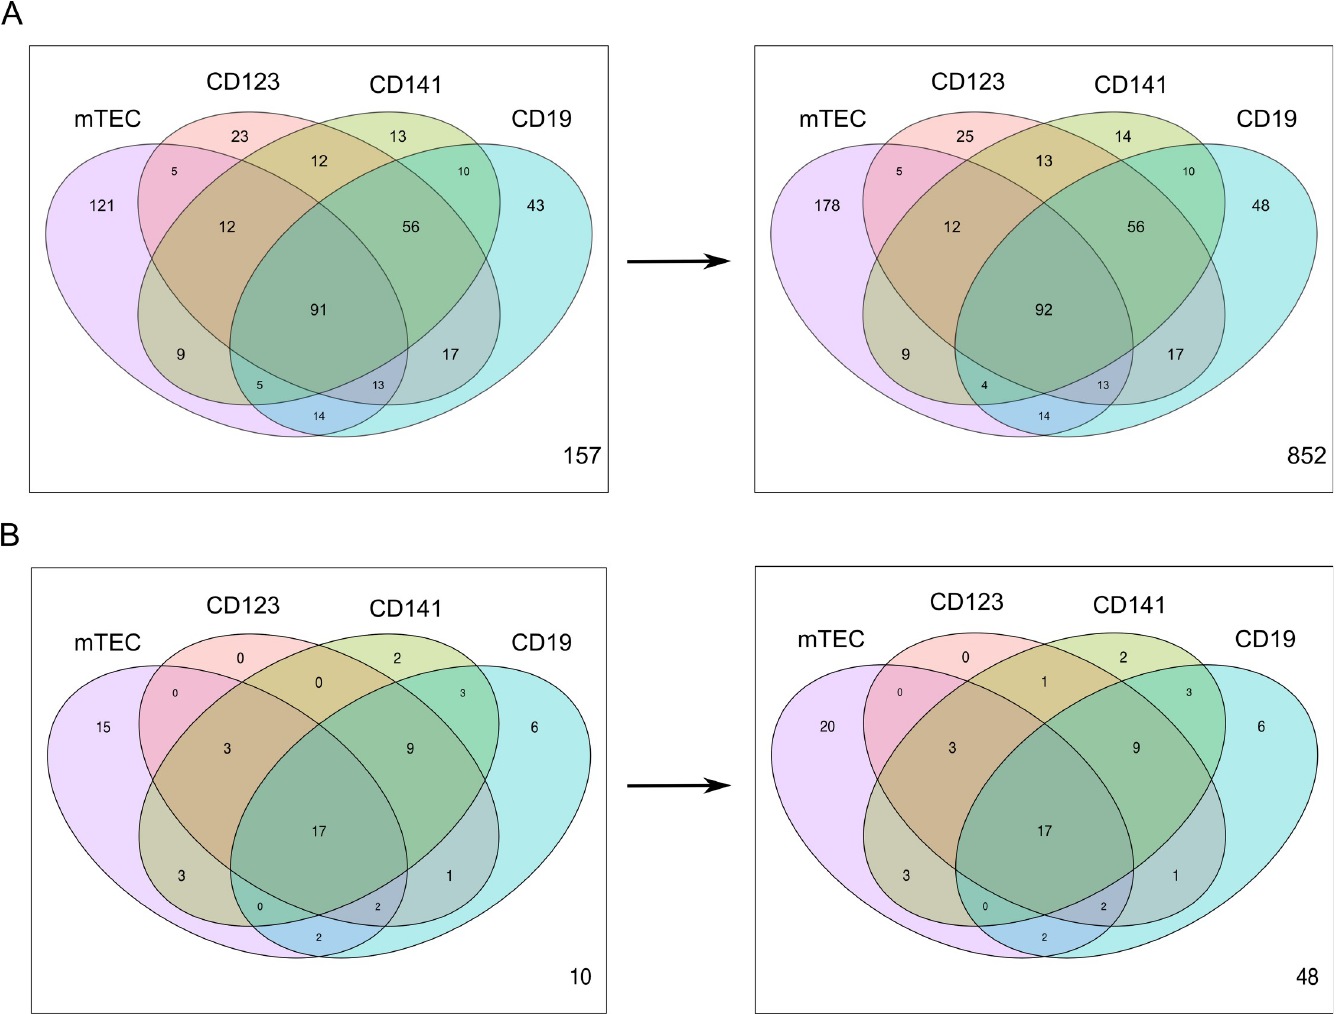
Fig 4. Uniquely and commonly expressed tissue enriched genes in the thymic APCs. Venn diagram showing the number of expressed (FPKM > 1) (A) tissue enriched genes and (B) tissue enriched genes that overlap with genes encoding human autoantigens reported in the Immune Epitope Database. The arrow indicates that the number of biological replicates that a gene needed to be expressed in to be included in the dataset changed from five to one. The number down in the right corner displays the number of genes with expression levels FPKM <